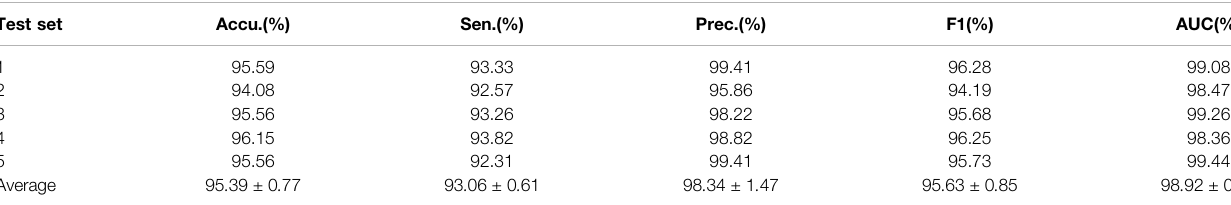
TABLE 2 | Result of fi vefold CV generated by SAAED on the CircR2Disease Dataset. Test set